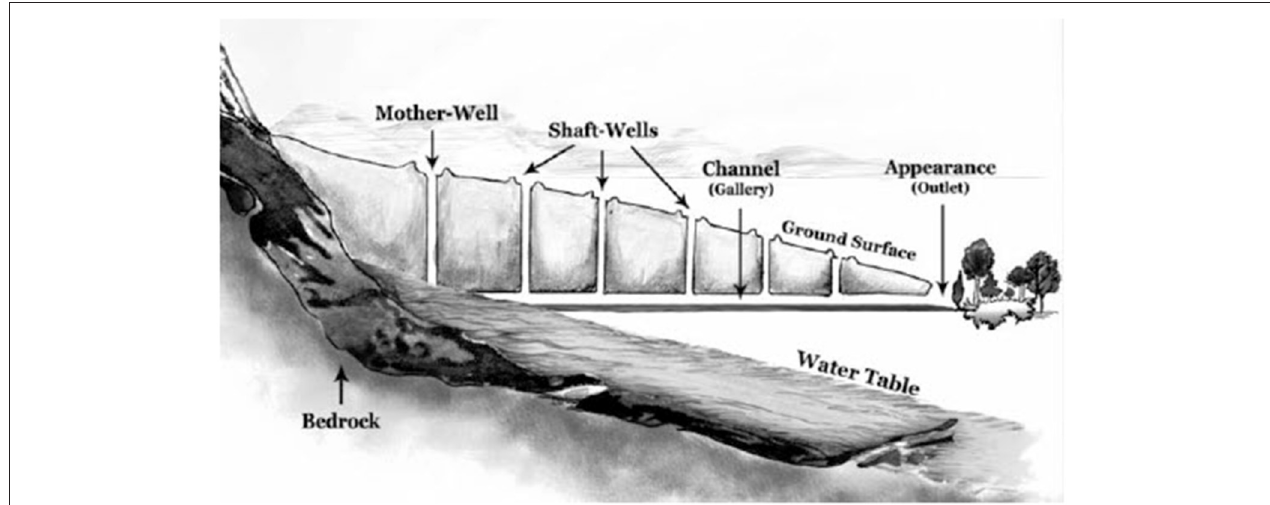
FIGURE 1 | Profile of a typical qanat (24,